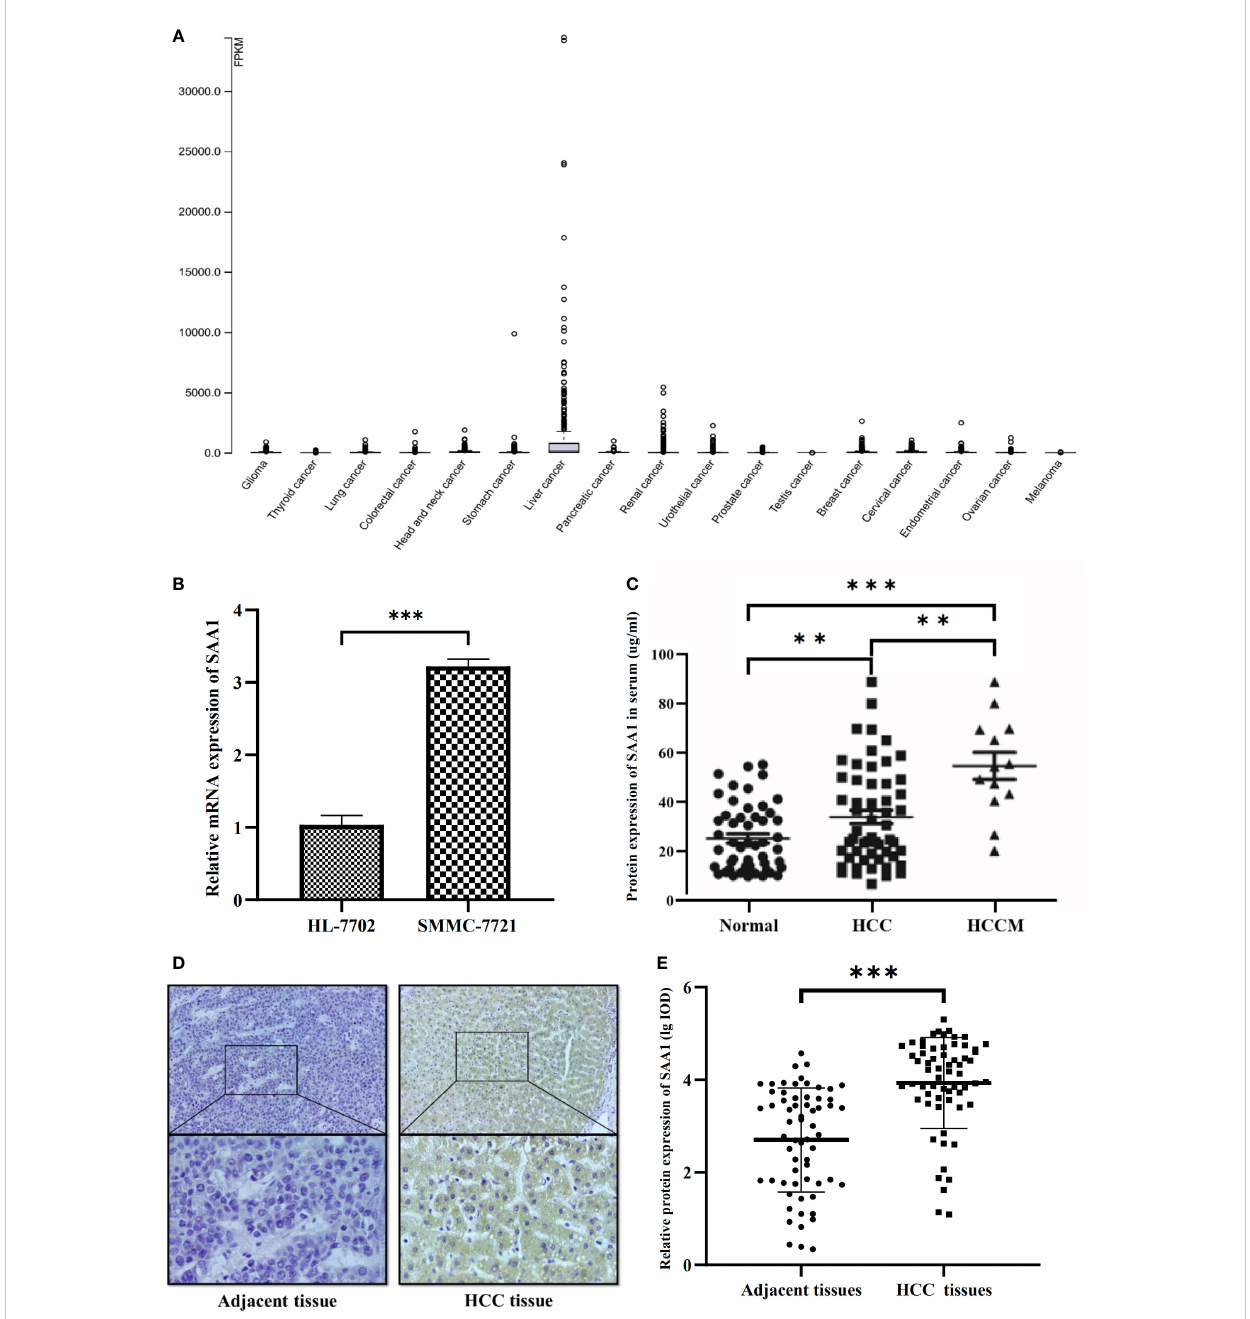
FIGURE 4 Expression of SAA1 in HCC. (A) SAA1 was highly expressed in liver cancer among various cancer category based on The Cancer Genome Atlas (TCGA) dataset. (B) SAA1 mRNA expression in SMMC-7721 cells and HL-7702 cells ( P < 0.001). (C) SAA1 concentrations in serum were veri fi ed in 52 healthy controls, 55 HCC patients and 13 HCC patients with metastasis (HCCM) using ELISA (** P < 0.01, *** P < 0.001). (D) Immunohistochemical staining for SAA1 expression in HCC and adjacent non-tumorous liver tissues, representative images of positive staining in HCC tissues and negative staining in adjacent non-tumorous liver tissues. (E) Immunohistochemical staining integrated optical density (IOD) value of SAA1 in HCC and adjacent non-tumorous liver tissues (n = 63, P <